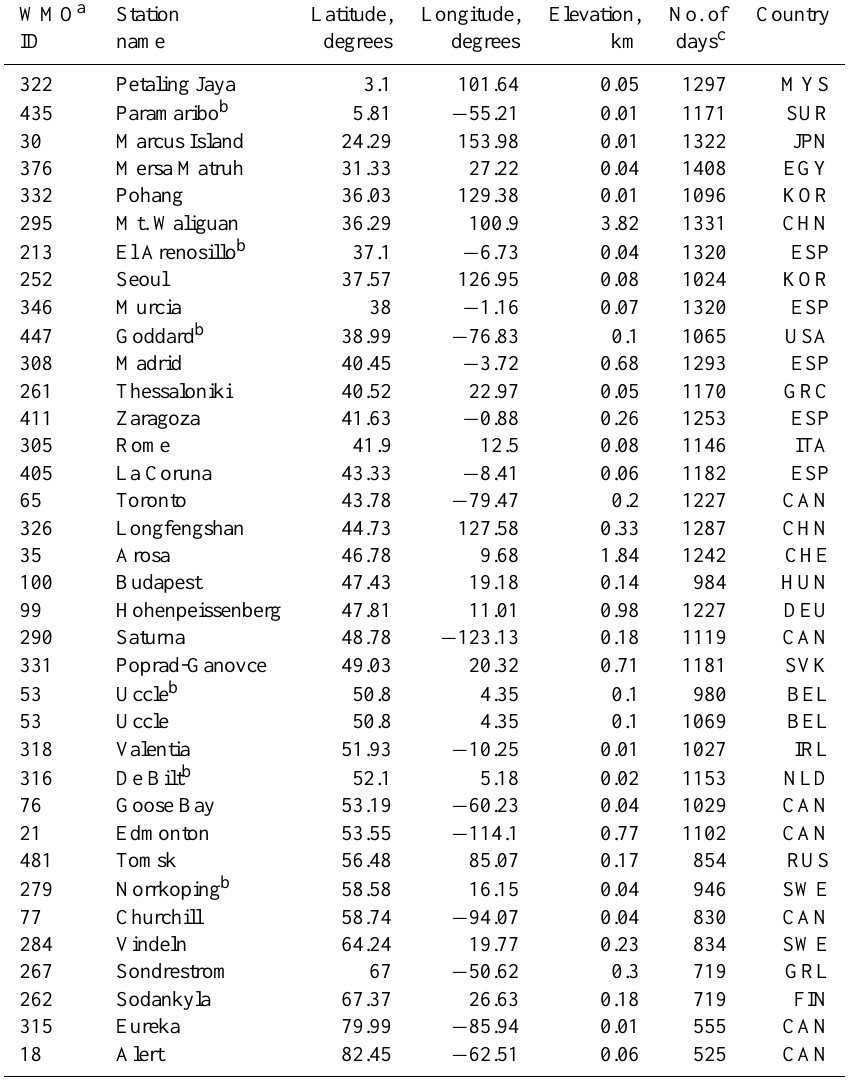
Table 2. Brewer stations selected from